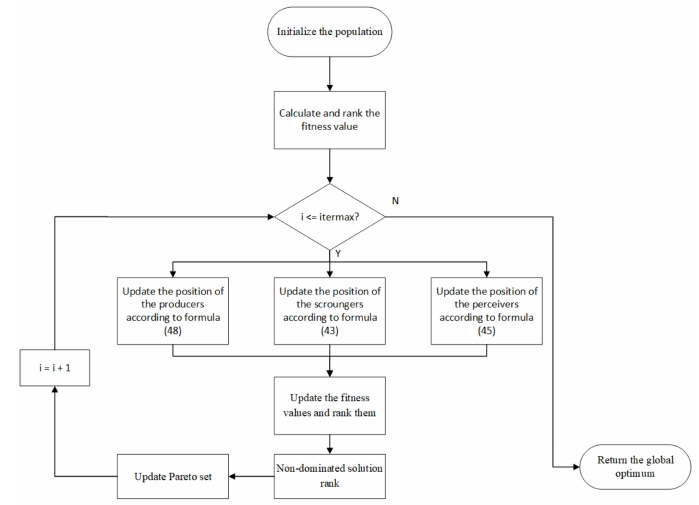
Figure 3. Flow chart of ISSA.